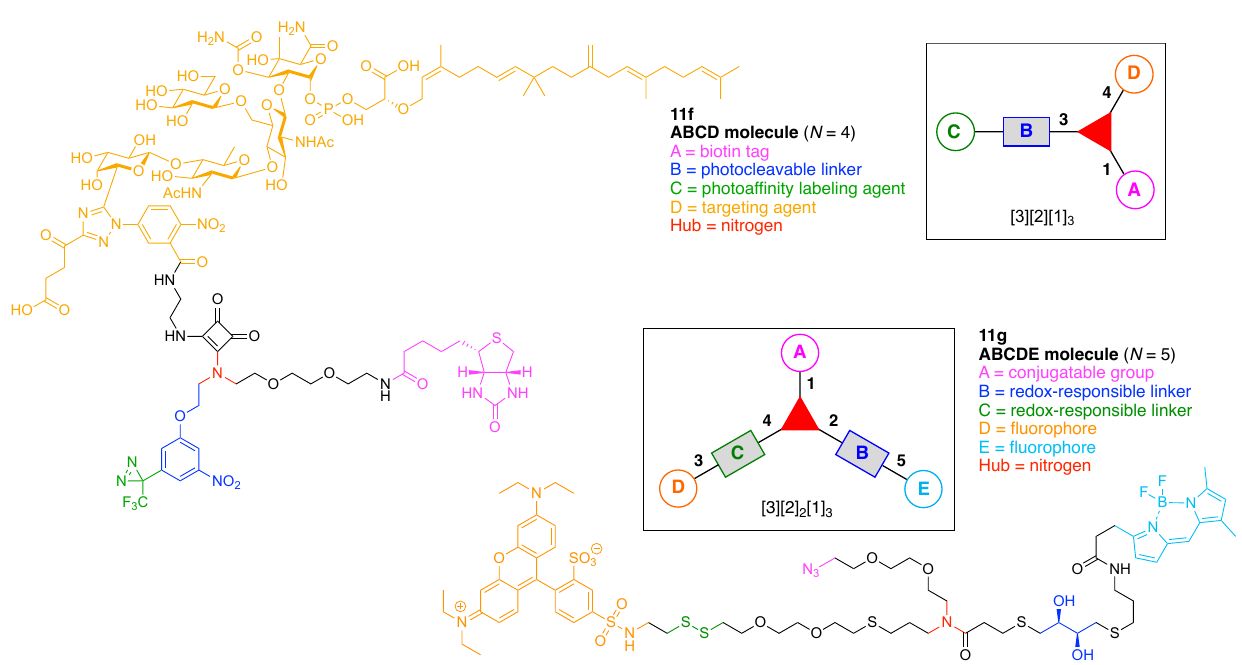
Organics 2021 , 2 , FOR PEER REVIEW Figure 55. Two examples each containing a single nitrogen hub. Figure 55. Two examples each containing a single nitrogen hub. A sequence-defined oligothioether-amide structure ( 11g ) was developed that con- tains heterotrifunctional cross-linkers with two orthogonal internal cleavage sites (Figure 55) [273]. The structure is built around a nitrogen hub and contains five functional units: (A) an azido group for click chemistry; (B) an oxidation-sensitive cleavable linker; (C) a reduction-sensitive cleavable linker; (D) rhodamine as a FRET acceptor, and (E) BODIPY as a FRET donor. This construct ( 11g ) has composition ABCDE and architecture [3][2] 2 [1] 3 . Cleavage of the linkers can be monitored owing to the presence of the FRET fluorophores. An amphiphile containing four steroidal heads and a polycationic tail ( 11h ) was de- veloped for delivery of small interfering RNA (siRNA) through cell membranes (Figure 56) [274]. The amphiphile is composed of a nitrogen hub, two lysine hubs, and six func- tional units: (A) four copies of cholic acid to construct a largely hydrophobic face; (B) a disulfide as a reduction-sensitive cleavable linker, and (C) a polycationic octaarginine peptide for binding to siRNA. This construct ( 11h ) has composition A 4 BC and architecture [3] 3 [2][1] 5 .